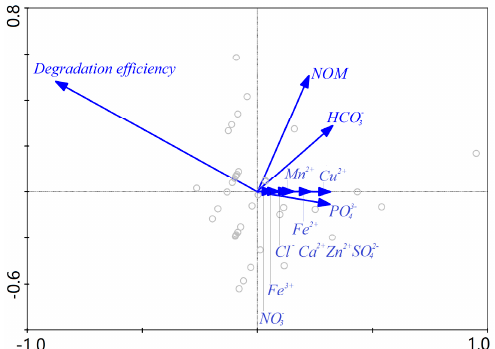
Figure 9. Redundancy analysis (RDA) analysis of influence of investigated water matrices.